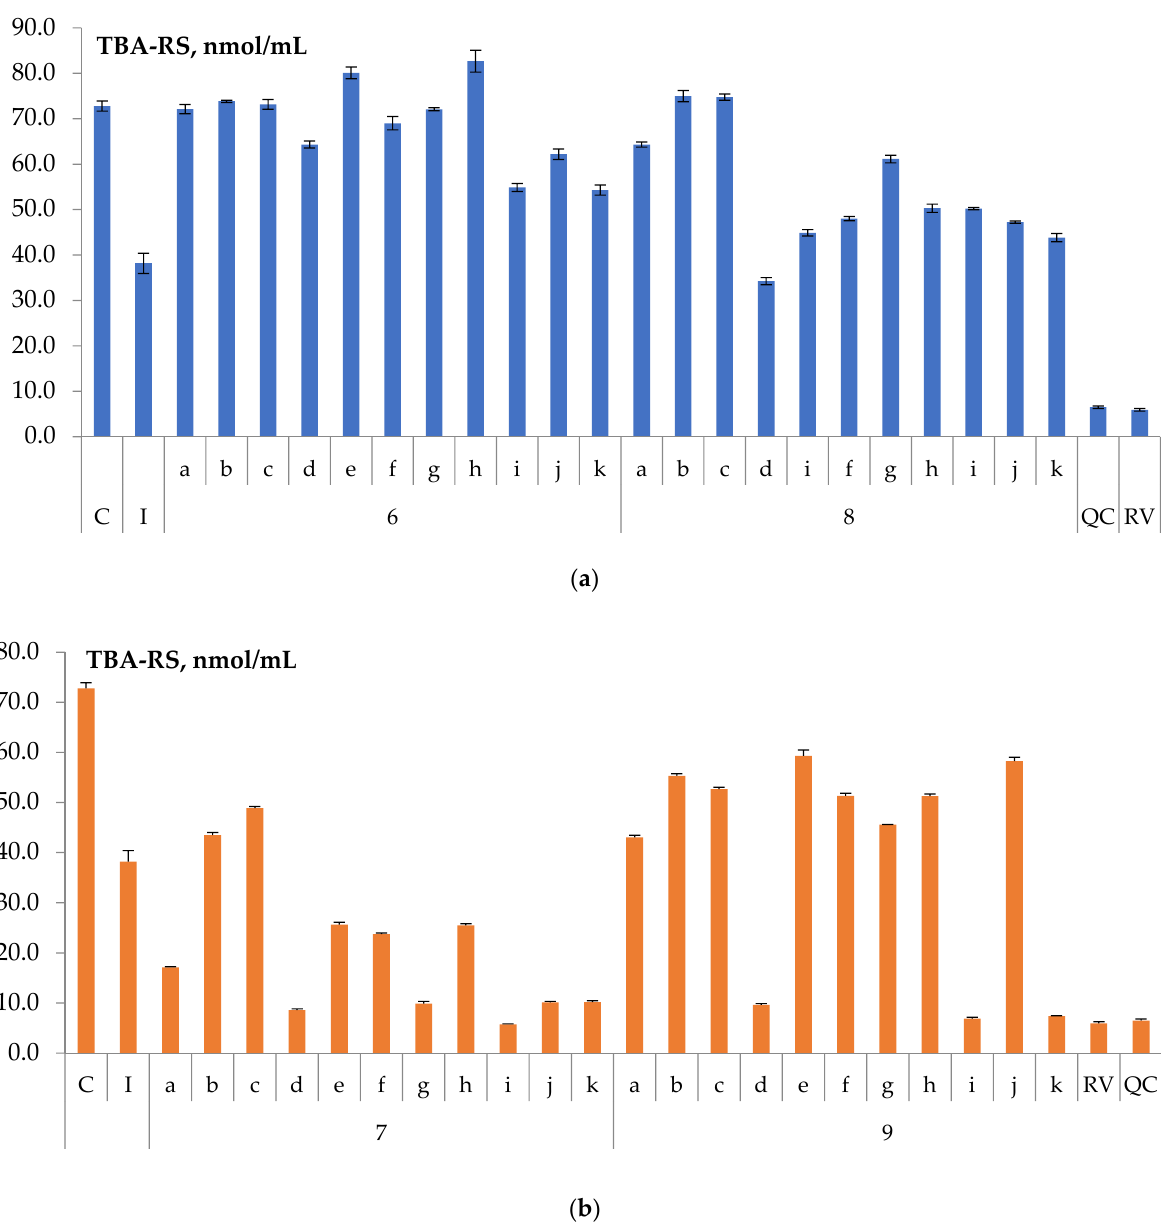
Figure 2. Antioxidant activity of chalcones and pyrazolines: ( a ) Chalcones 6a – k and 8a – k ; ( b ) Pyrazolines 7a – k and 9a – k . С —control; I-intact; RV—resveratrol; QC—quercetin. Thus, in this model system, no AOA was detected for chalcones containing nitro group ( 6a and 8a ) or halogen atoms ( 6b , c and 8b , c ) in the aromatic ring B. The presence of